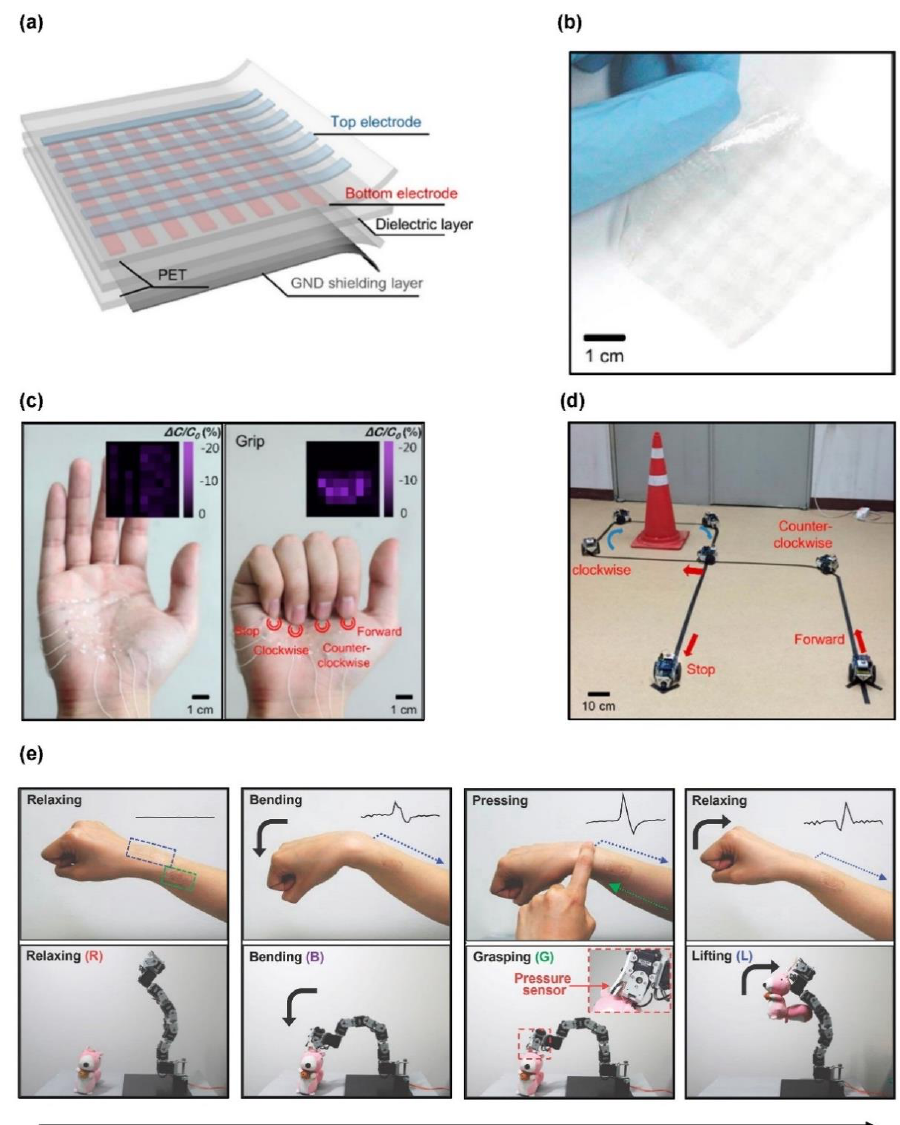
Figure 5. Graphene-based wearable sensors for a human-machine interface: ( a ) schematic illustration of a graphene-based capacitive sensor consisting of two graphene electrodes layers and an intermediate dielectric layer; ( b ) optical camera image of 64-channel touch sensor array; ( c ) images of stretchable touch sensor mounted on a palm for remote control application. Inset: capacitance changes for spread (left) and grip (right) status of the palm; and ( d ) images of a toy car operated by the stretchable remote control in c. Reproduced with permission from Kang et al. [158], copyright 2017, American Chemical Society. ( e ) The transparent motion sensor and the electrotactile stimulator attached on the wrist and forearm, respectively. The bending, pressing, and relaxing of the wrist lead to the bending, grasping, and lifting of the robot arm, respectively. Reproduced with permission from Lim et al. [160], copyright 2014,